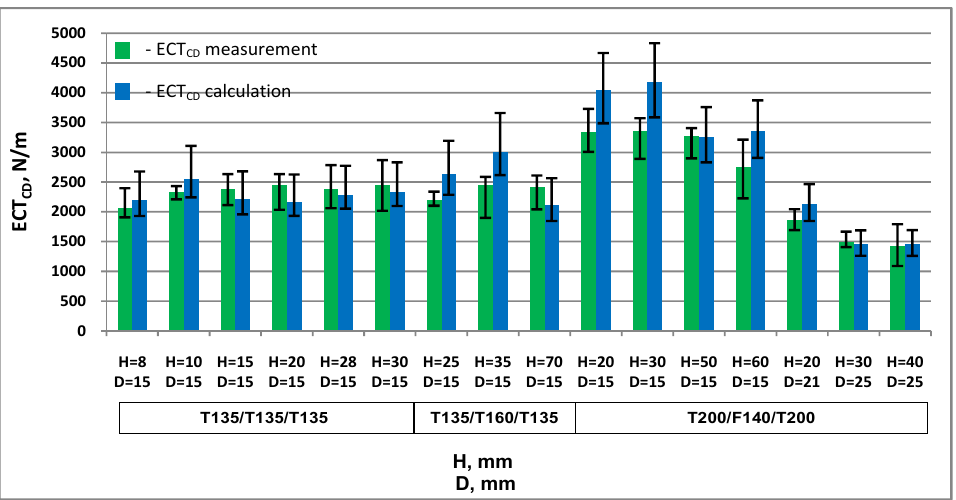
Figure 8. Resistance of honeycomb paperboard to edge crushing in the cross direction.